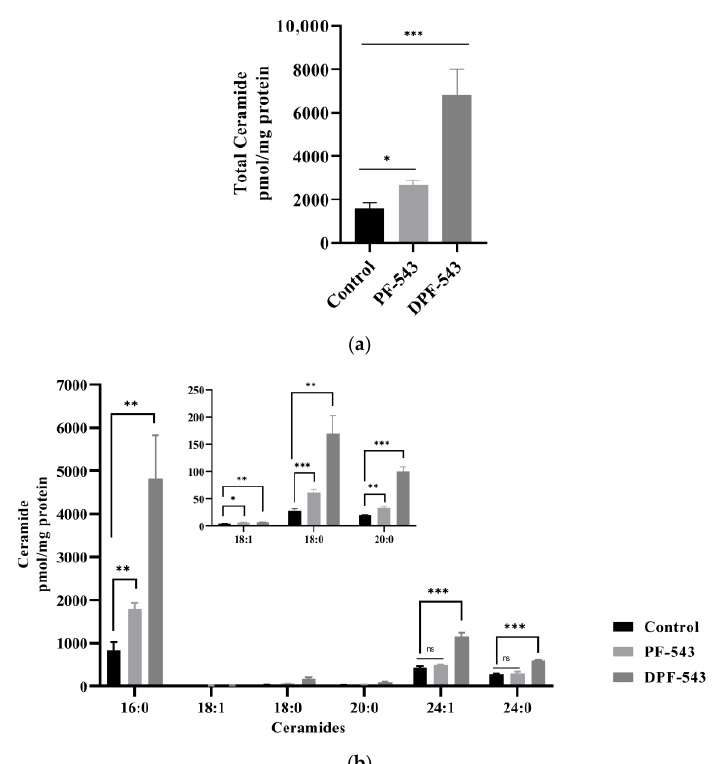
Figure 6. ( a ) Total endogenous ceramide accumulation by SPHK1 inhibitors; ( b ) alteration of endogenous ceramides by SPHK1 inhibitors. Data are shown as means ± SD, ns—not significant, * p < 0.05, ** p < 0.01, *** p < 0.001.